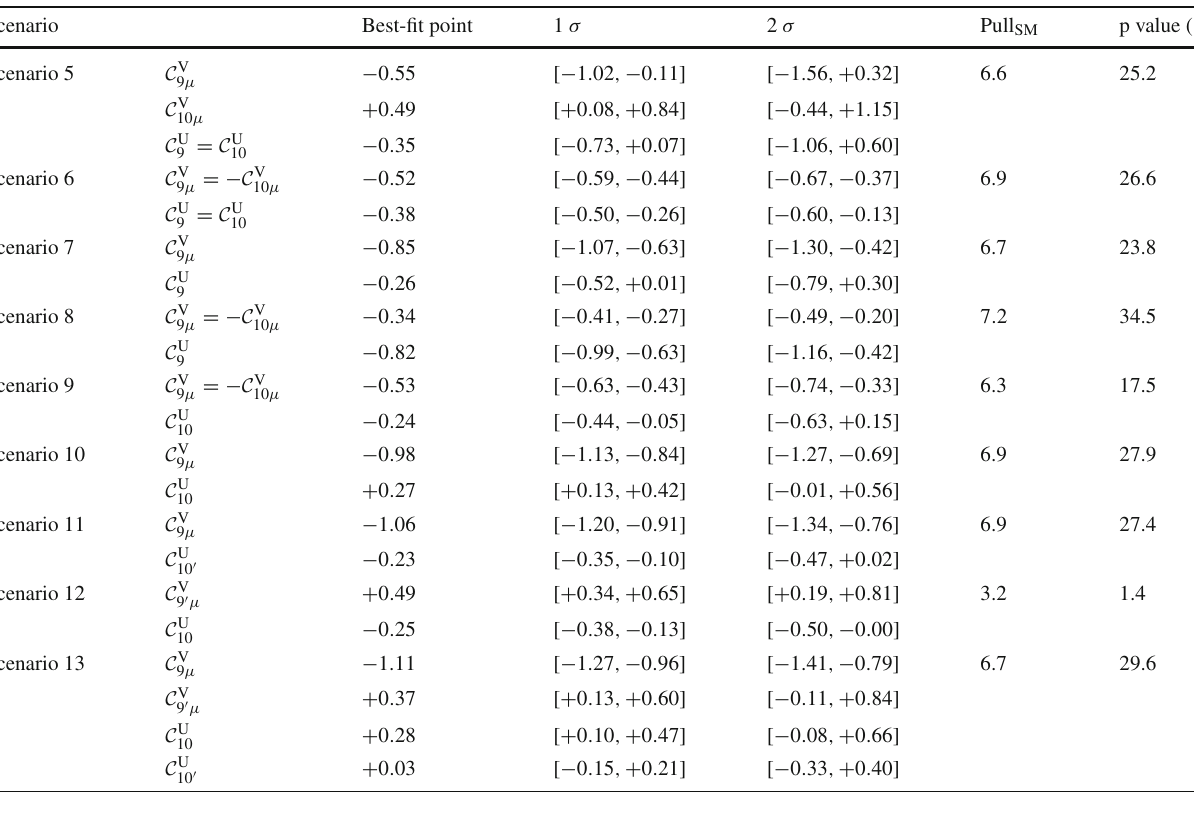
Table 4 Most prominent patterns for LFU and LFUV NP contributions from Fit “All”. Scenarios 5 to 8 were introduced in Ref. [8]. Scenarios 9 (motivated by 2HDMs [66]) and 10–13 (motivated by Z (cid:4) models with vector-like quarks [67]) were introduced in Ref. [9]